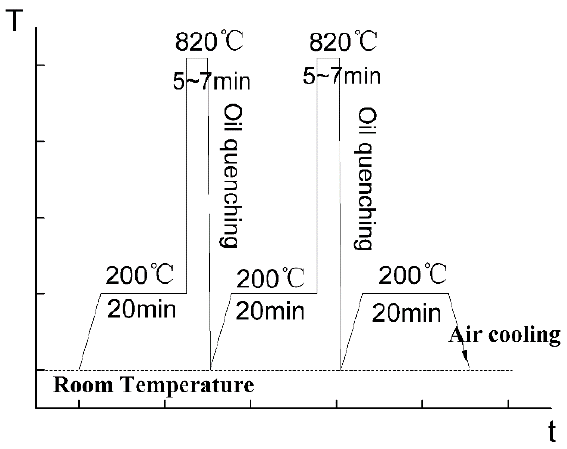
Figure 7. Circulating quenching processing of 40Cr.